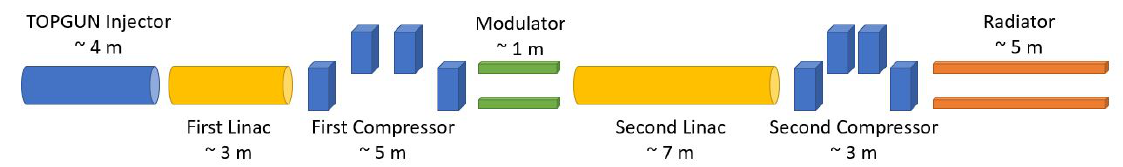
Figure 3. The schematic shows, in a simplified manner, the various elements present in the beamline as well as their approximate sizes. Altogether, the system should remain extremely compact at a total length of less than 30